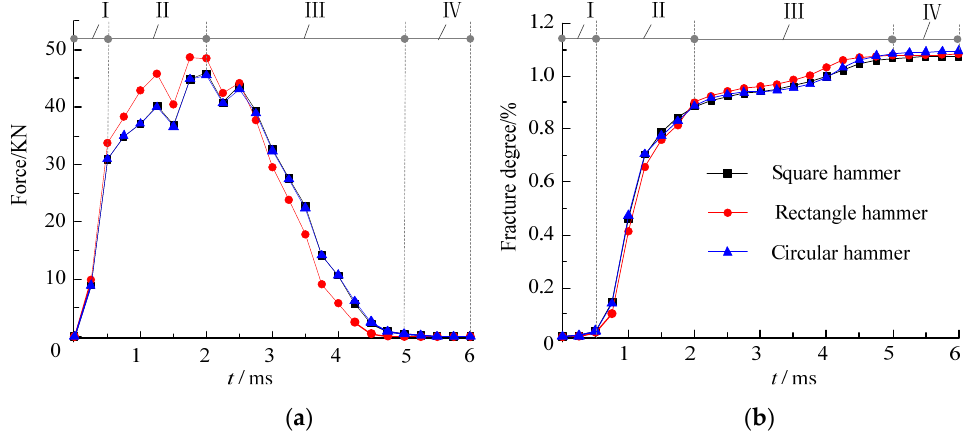
Figure 6. Impact-force and rupture-degree curves under different hammer impacts: ( a ) impact-force curves; ( b ) rupture-degree curves.